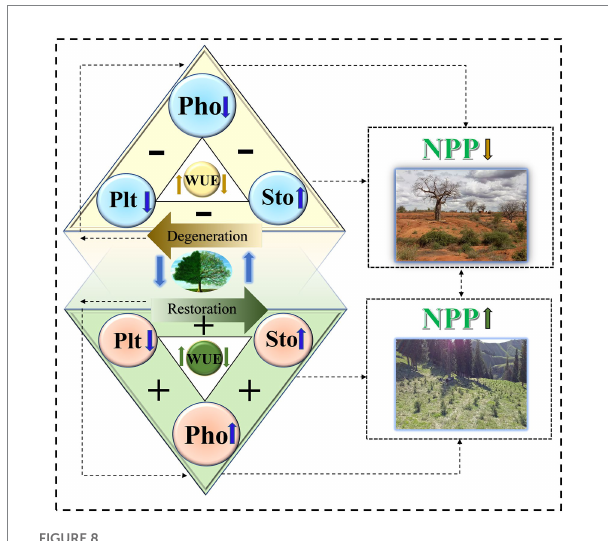
FIGURE 8 Mechanism of WUE and NPP